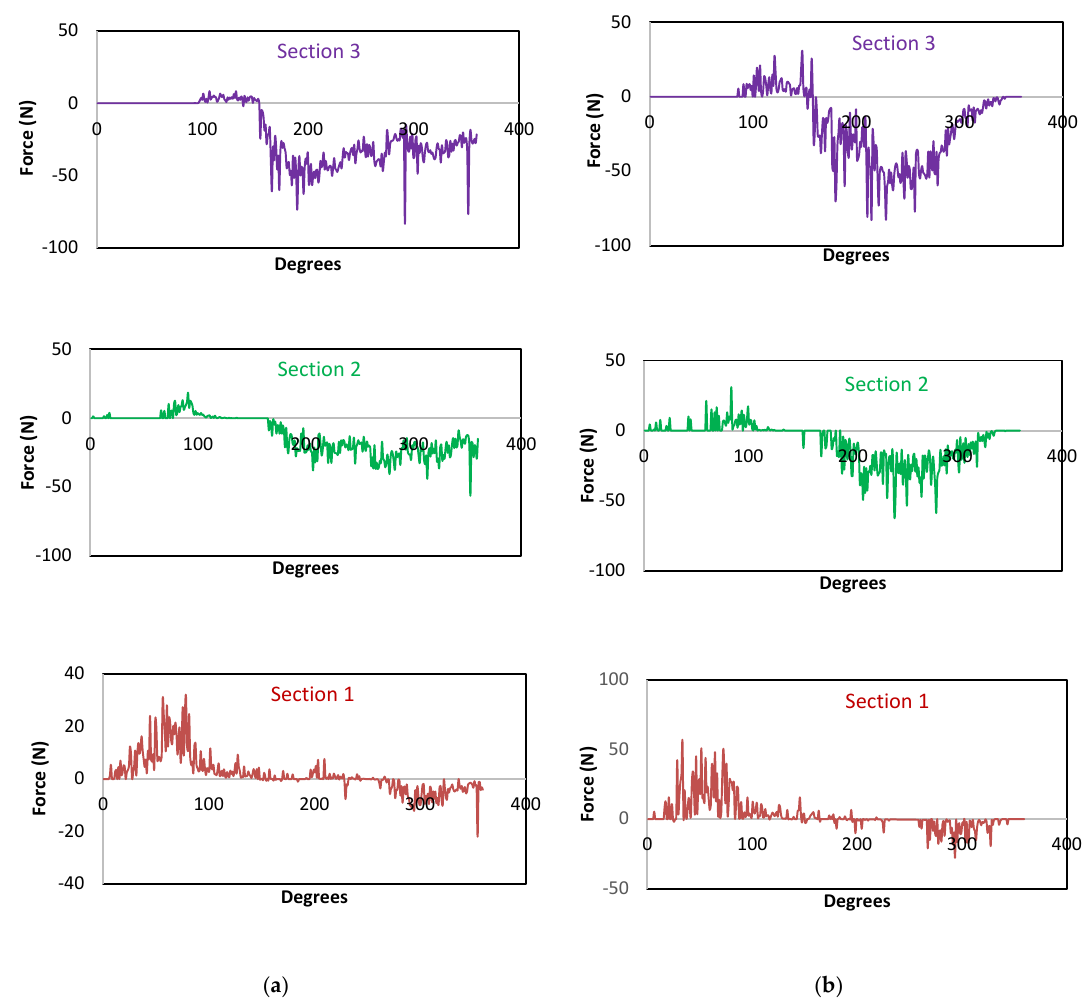
Figure 14. Comparison of end liner tangential forces for the ( a ) 25 mm balls and ( b ) 35 mm balls.